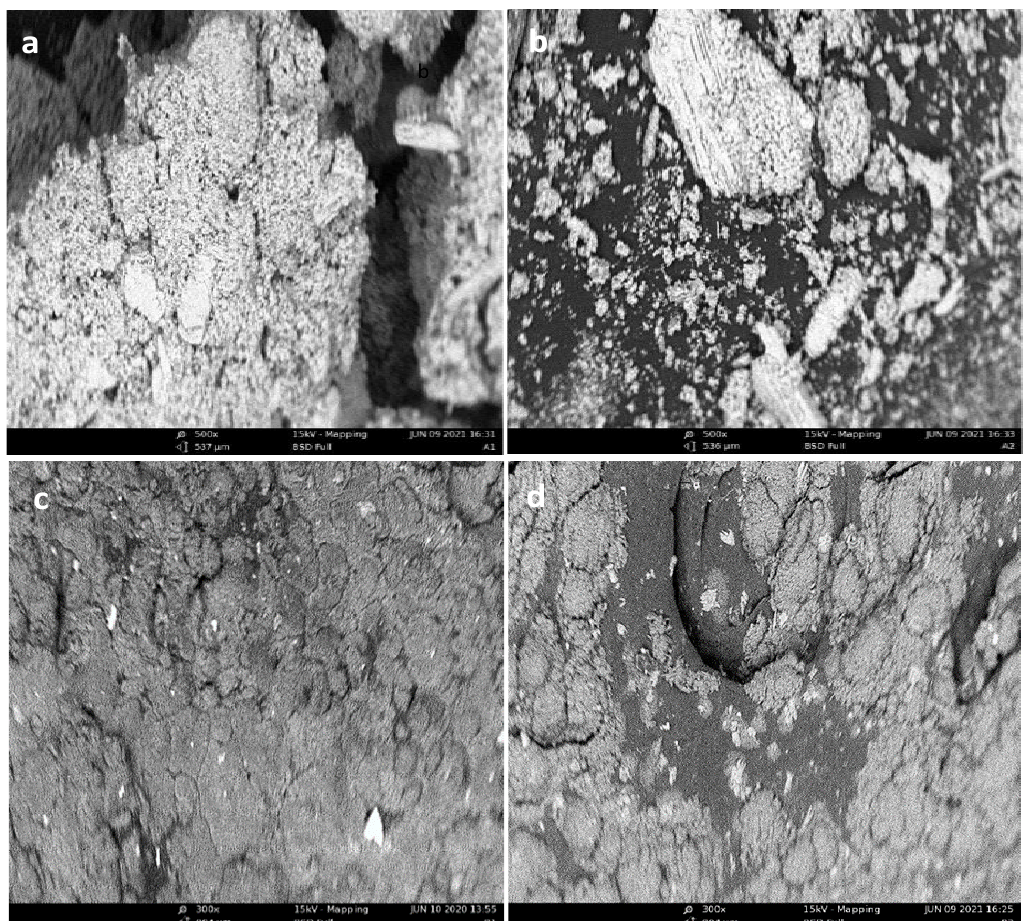
Figure 1: SEM Images of synthesized (a) ScCSNPs (b) ScCSNPs-AgNPs (c) ArCSNPS (d) ArCSNPS-AgNPs Fig.1 . SEM Images of synthesized (a) ScCSNPs (b) ScCSNPs-AgNPs (c) ArCSNPS (d)